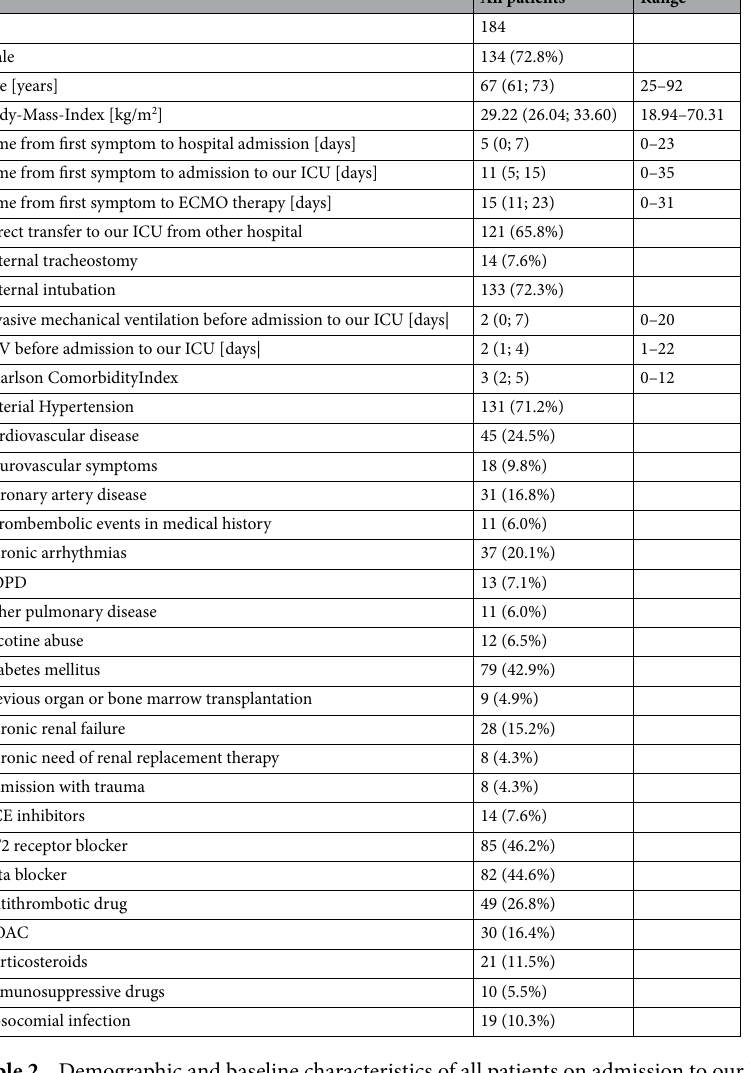
Table 2. Demographic and baseline characteristics of all patients on admission to our ICU. Data are median (Interquartile range) or n (%). ICU Intensive care unit, ECMO extracorporeal membrane oxygenation, NIV non-invasive ventilation, COPD chronic obstructive pulmonary disease, ACE angiotensin-converting enzyme, AT2 Angiotensin II, DOAC Direct oral